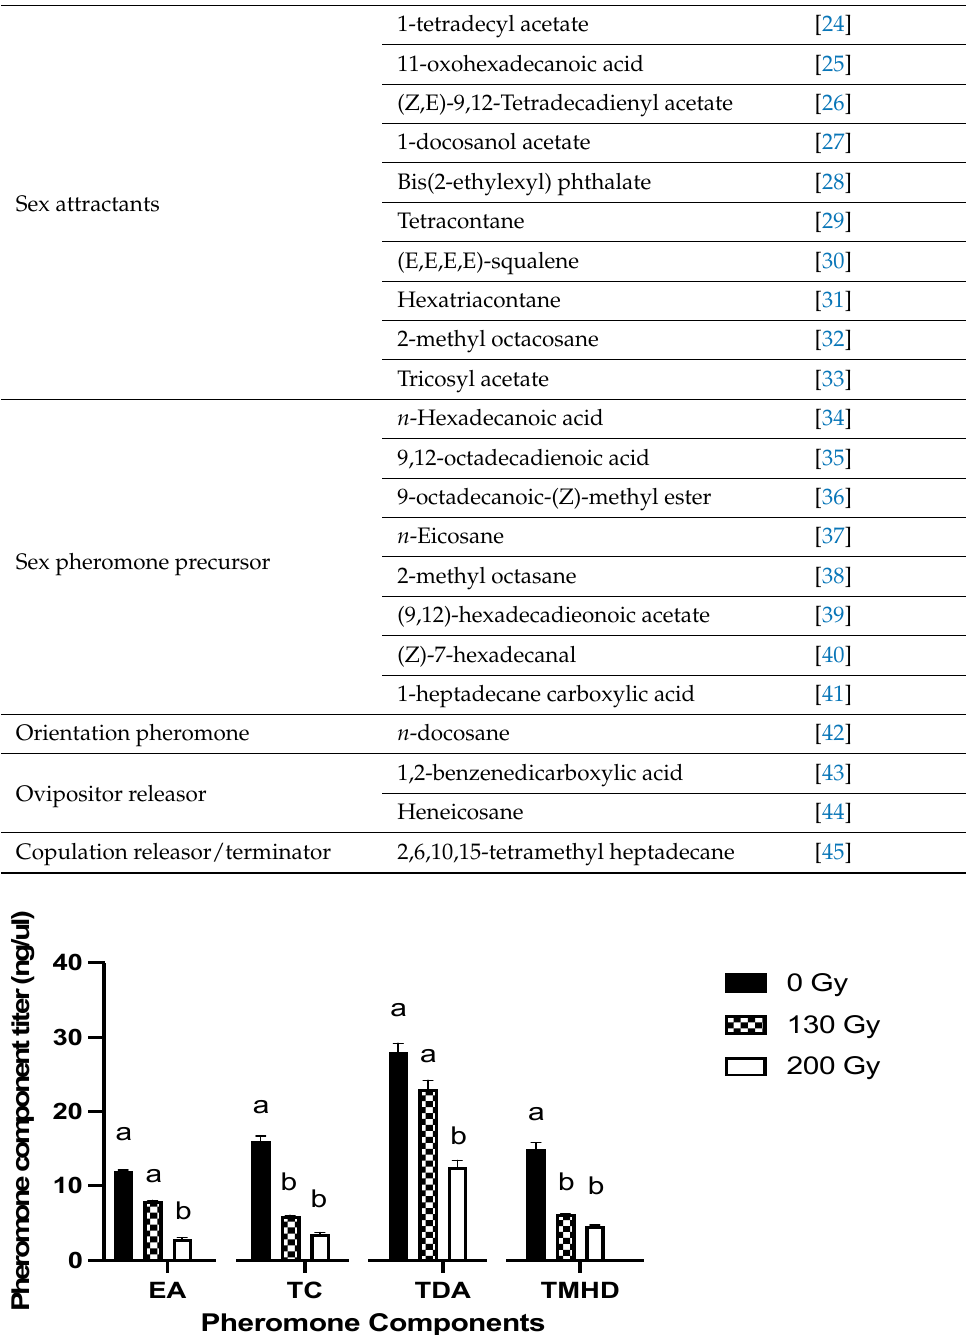
Figure 2. Effect of radiation on titers of major pheromone components of female Spodoptera litura . EA-Eicosyl acetate, TC-Tetracontane, TDA-(Z,E)-(9,12)-Tetradecadienyl acetate, TMHD-2,6,10,15-Tetramethyl heptadecane. Means ± SE followed by the same letters within each pheromonal component are not statistically different at p < 0.05 (one-way ANOVA followed by Tukey’s multiple comparison test). Average reading in a sample pool of 10 adult female pheromone glands (PGs) constituted one replicate ( n =